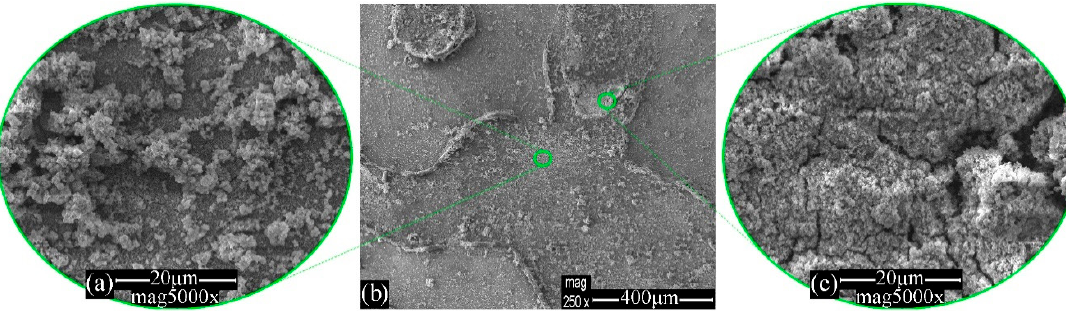
Figure 8. SEM images of mild steel immersed in 3.5 wt % NaCl for 96 h in the presence of Na 2 HPO 4 .